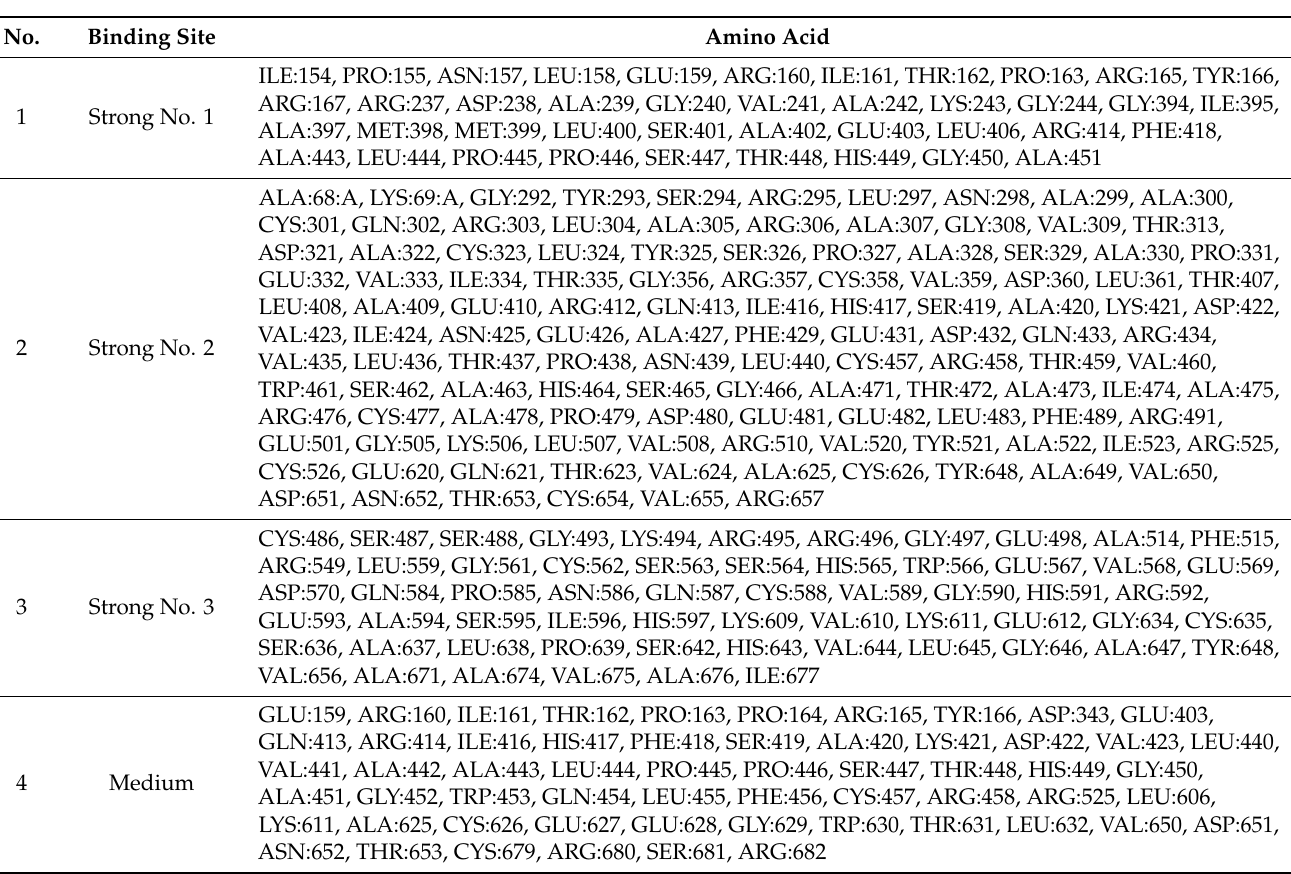
Table 10. The pocket binding site of